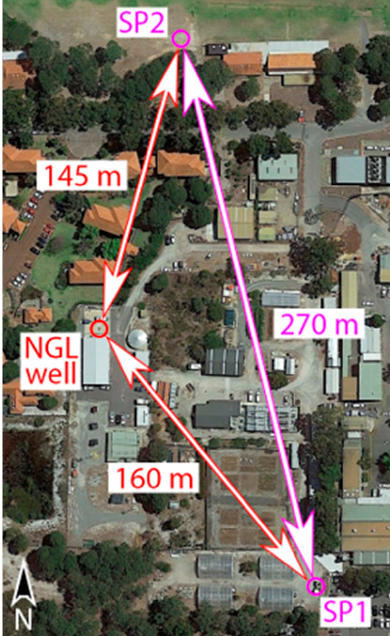
Figure 1. The map of the experiment with vibroseis sources at Curtin campus, with the wellhead and two source locations (SP1 and SP2) marked by circles.